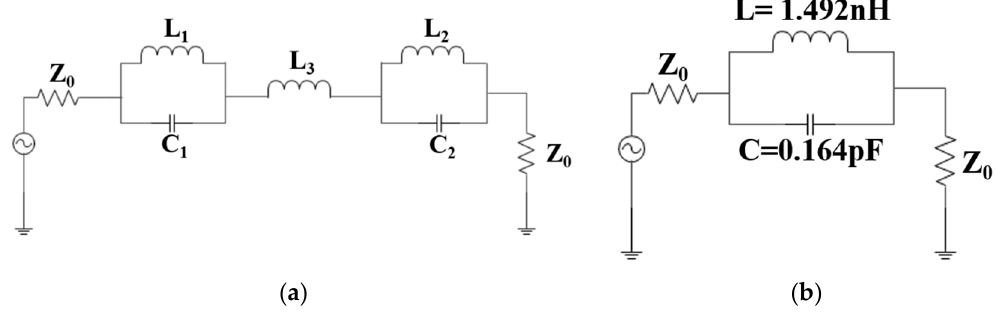
Figure 10. ( a ) The equivalent circuit of the proposed pair of EBG unit cells; ( b ) A simplified circuit.